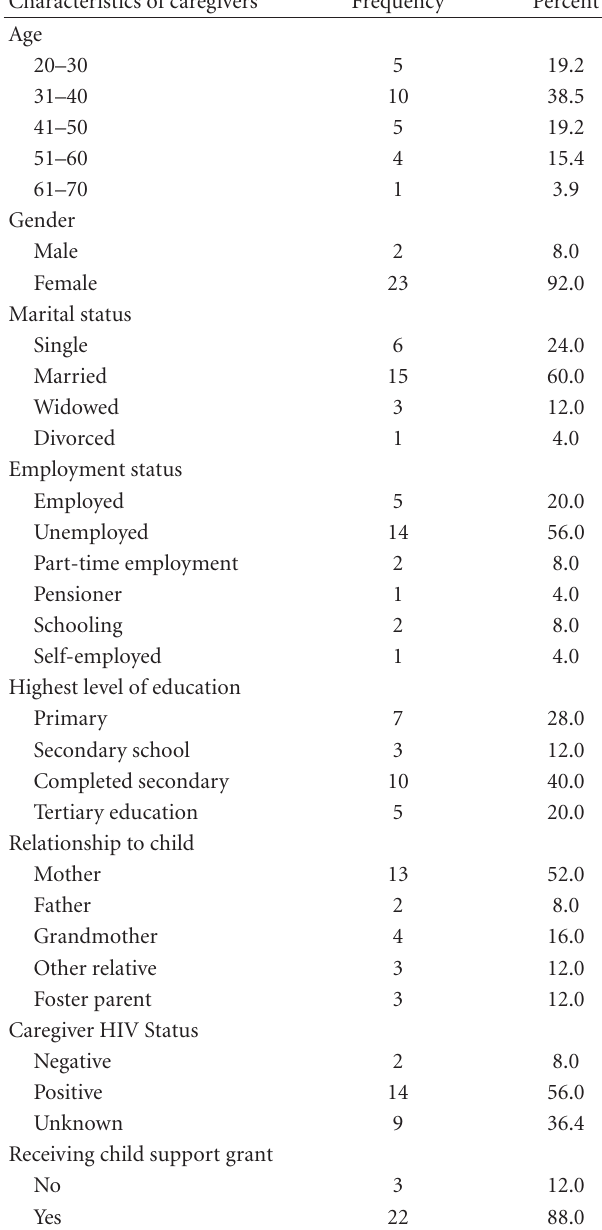
Table 1: Demographic information of caregivers ( n =